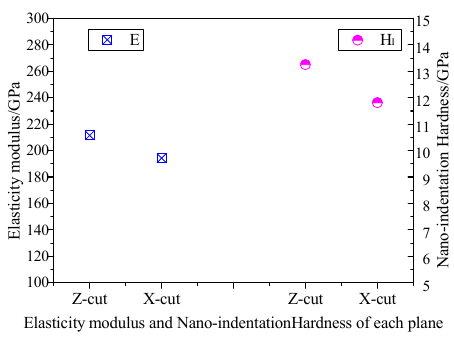
Figure 6. The indentation morphology by nano-indentation experiments.